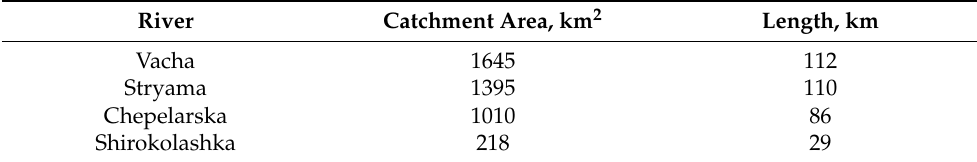
Table 6. Catchment area and length of the studied rivers. River Catchment Area, km 2 Length, km Vacha 1645 112 1395 110 1010 86 218